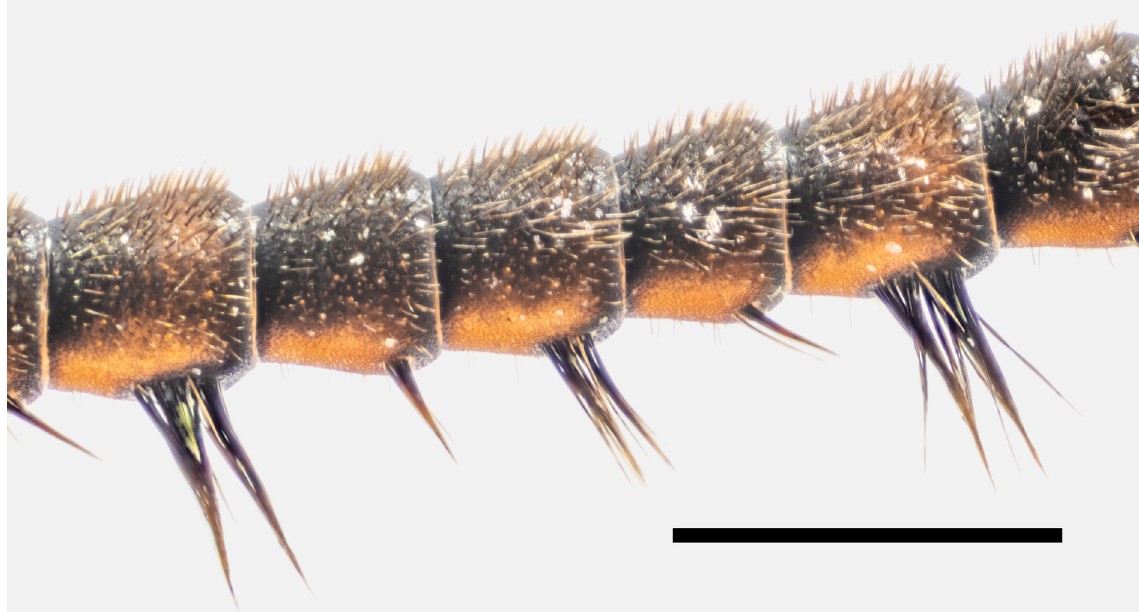
Fig. 5. Pleioplectron simplex Hutton, 1896, adult ♂, Hinewai Reserve, Banks Peninsula (MPN CW4109). Detail of antenna showing sensory hairs. Scale bar = 1